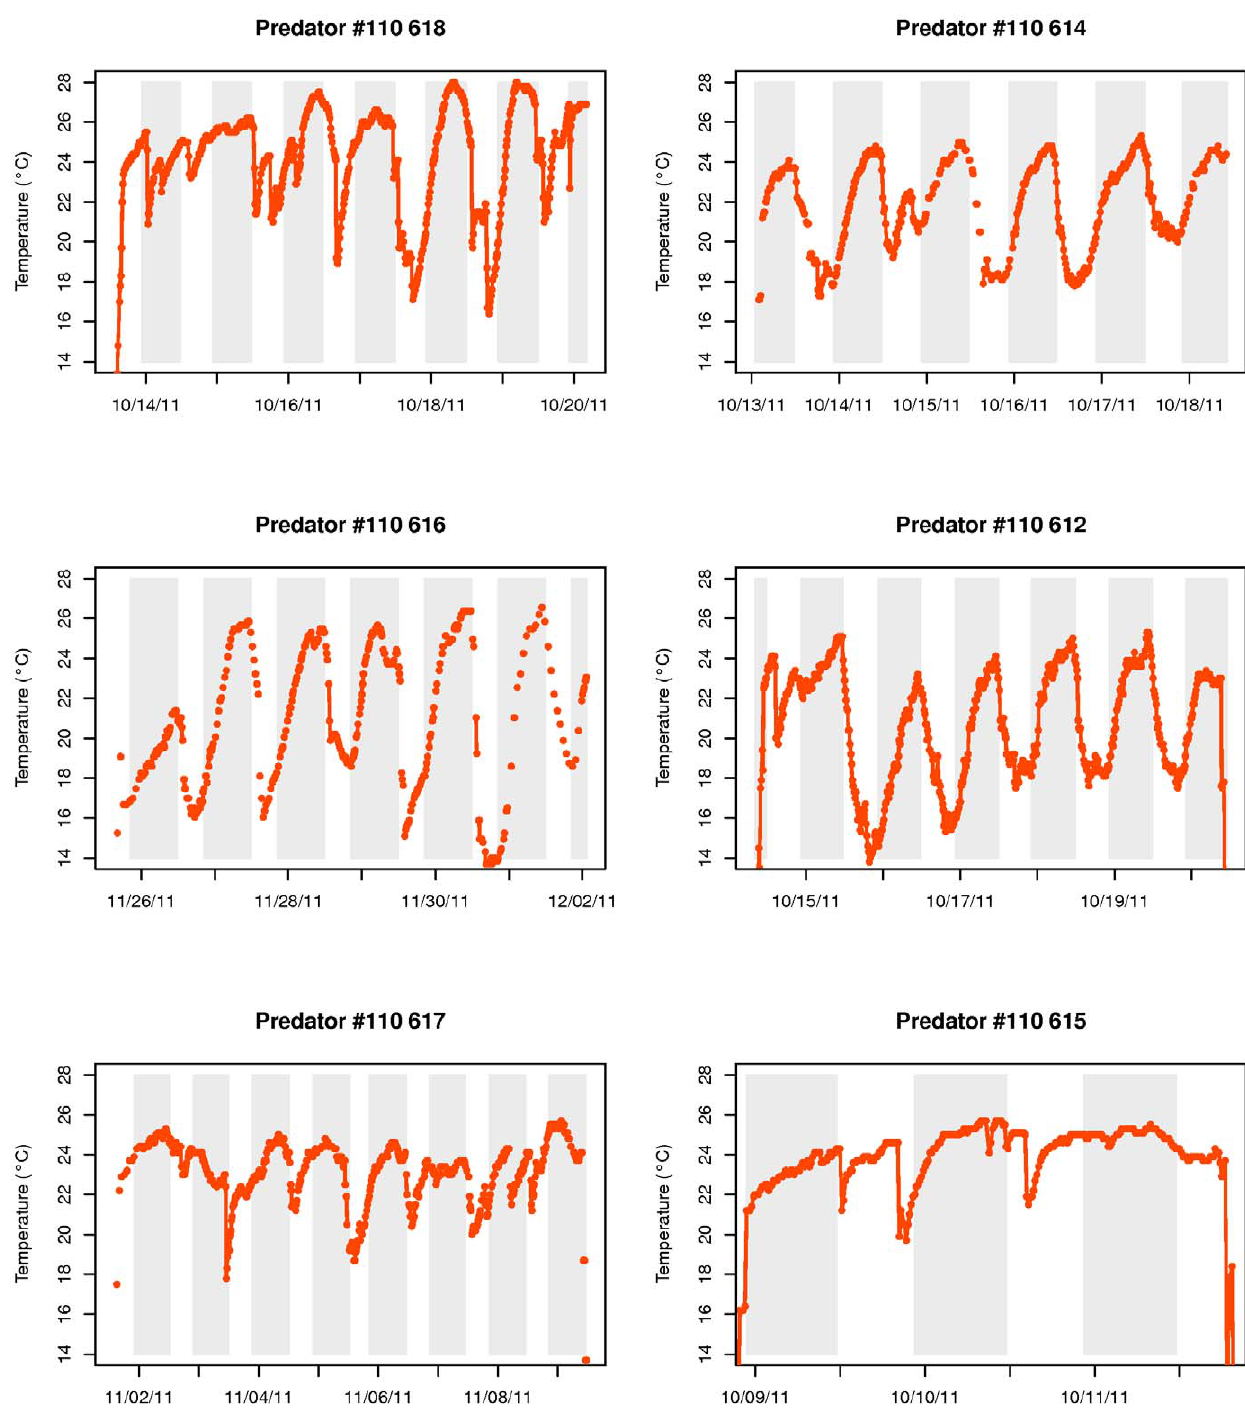
Figure 3. Temperature profile inside the guts of the 6 eel predators. The gray parts represent night period. doi:10.1371/journal.pone.0046830.g003 given that water temperatures in the Gulf of St. Lawrence during October are invariably below 9 u C. As gut temperatures are well below that expected of marine mammals (exceeding 38 u C in grey seals ( Halichoerus grypus ) [19]), we are left with two homeothermic fishes that occur in the Gulf as likely candidates: the Atlantic bluefin tuna and the porbeagle shark. Carey and Teal [27] reported that porbeagle muscle tissue was maintained 7–13 u C